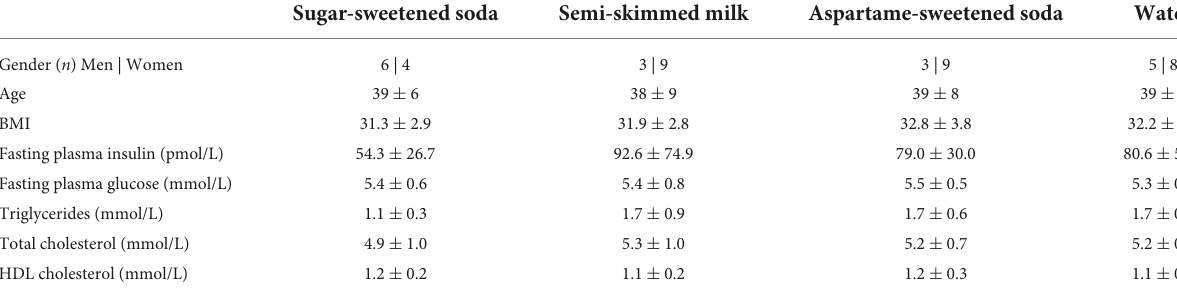
TABLE 1 Baseline